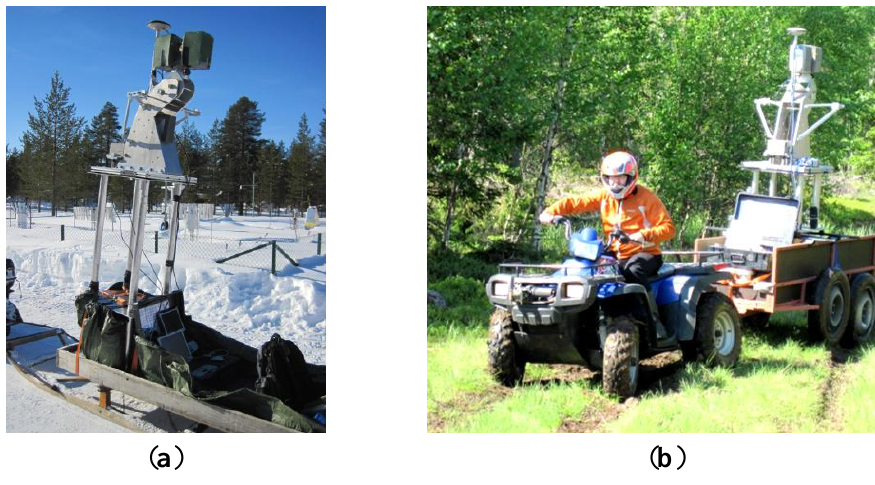
Figure 8. ( a ) A snowmobile application for studying the characteristics of and changes in snow cover; ( b ) an all-terrain vehicle towing the MLS when mapping in non-snow conditions.